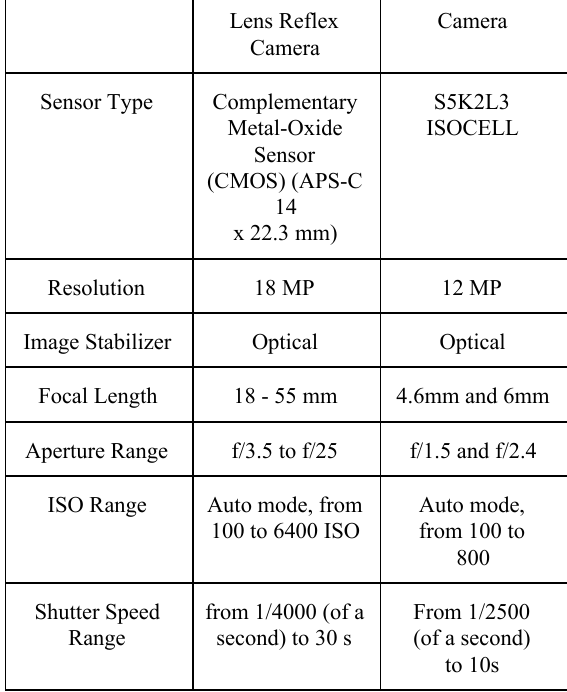
Table 1. Specification of the cameras used in the study